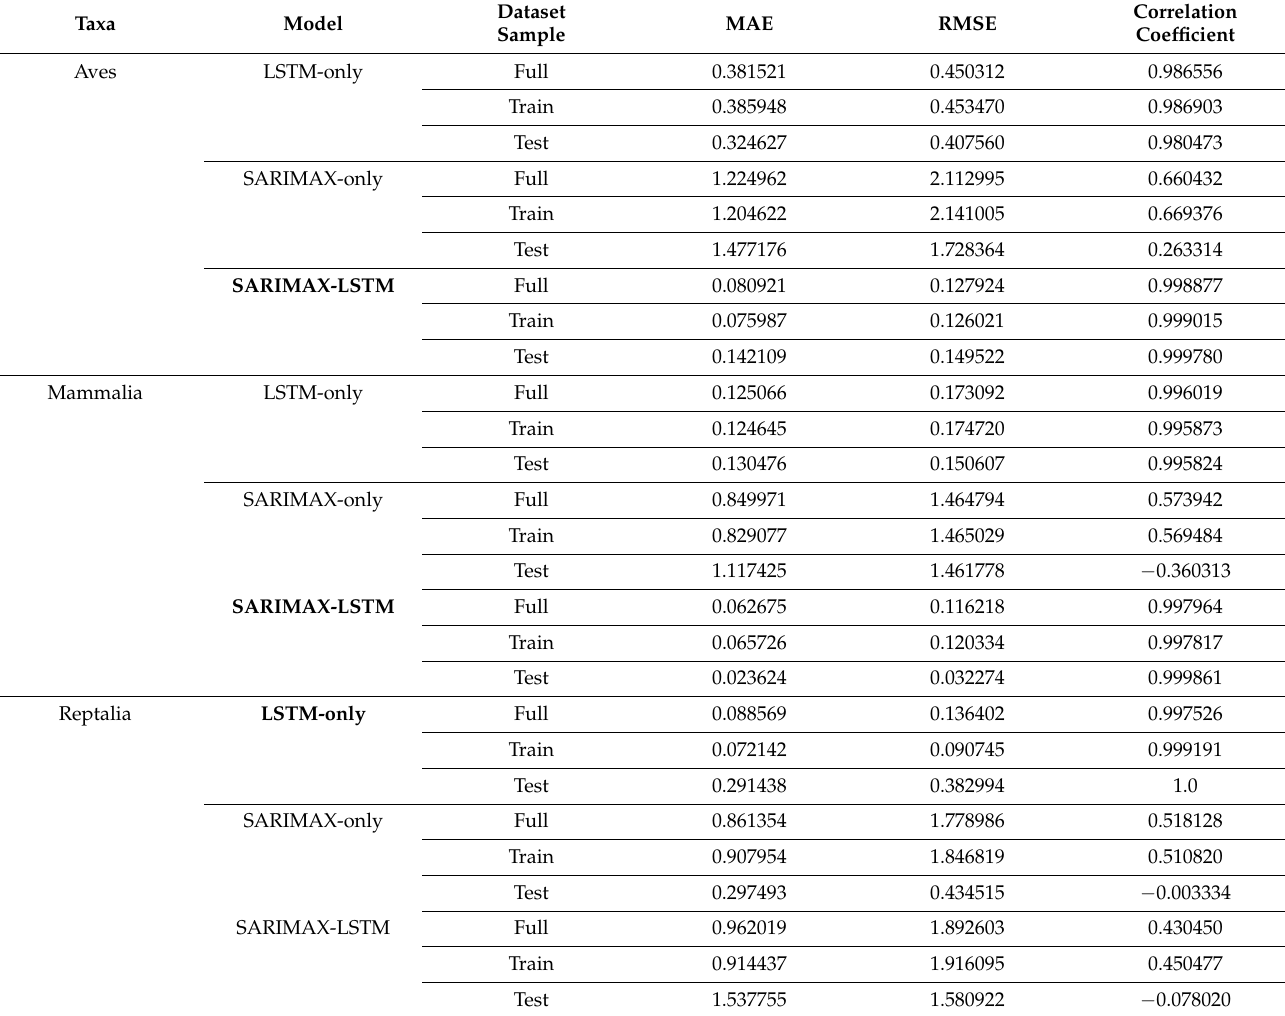
Table 8. Prediction performance of models showing error values of SARIMAX-only, SARIMAX- LSTM, and LSTM-only for each taxon. For each dataset, the best values of the metrics and model are highlighted in bold and their generalization correlation coefficient is a very high positive correlation, meaning the actual and predicted data are strongly correlated, as shown in Table